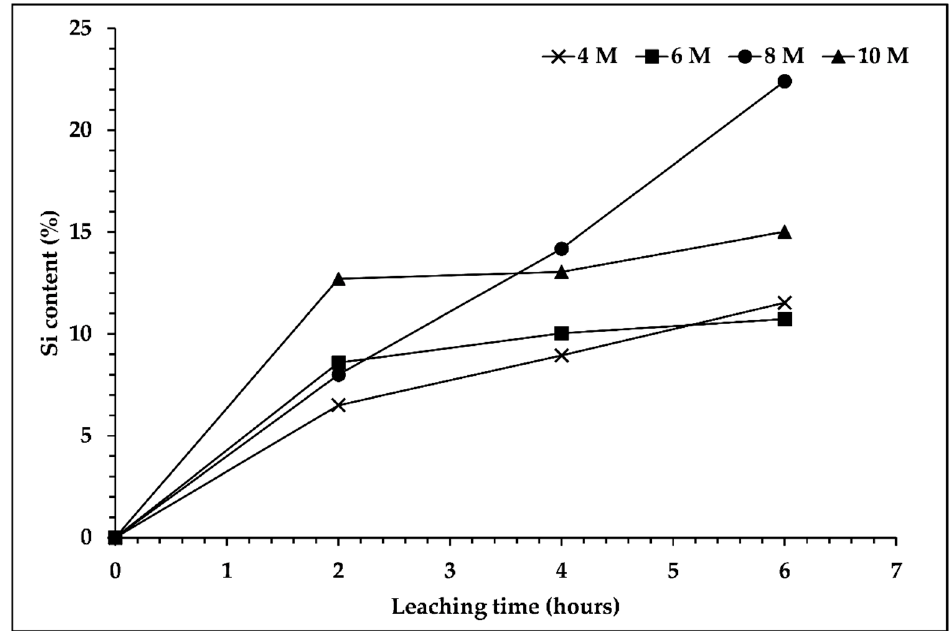
Figure 2. Effect of sodium hydroxide concentration and leaching time on silicon content in the leaching filtrate. Leaching process was performed at temperature of 95 °C, s/L ratio 1/10, and 300 rpm.